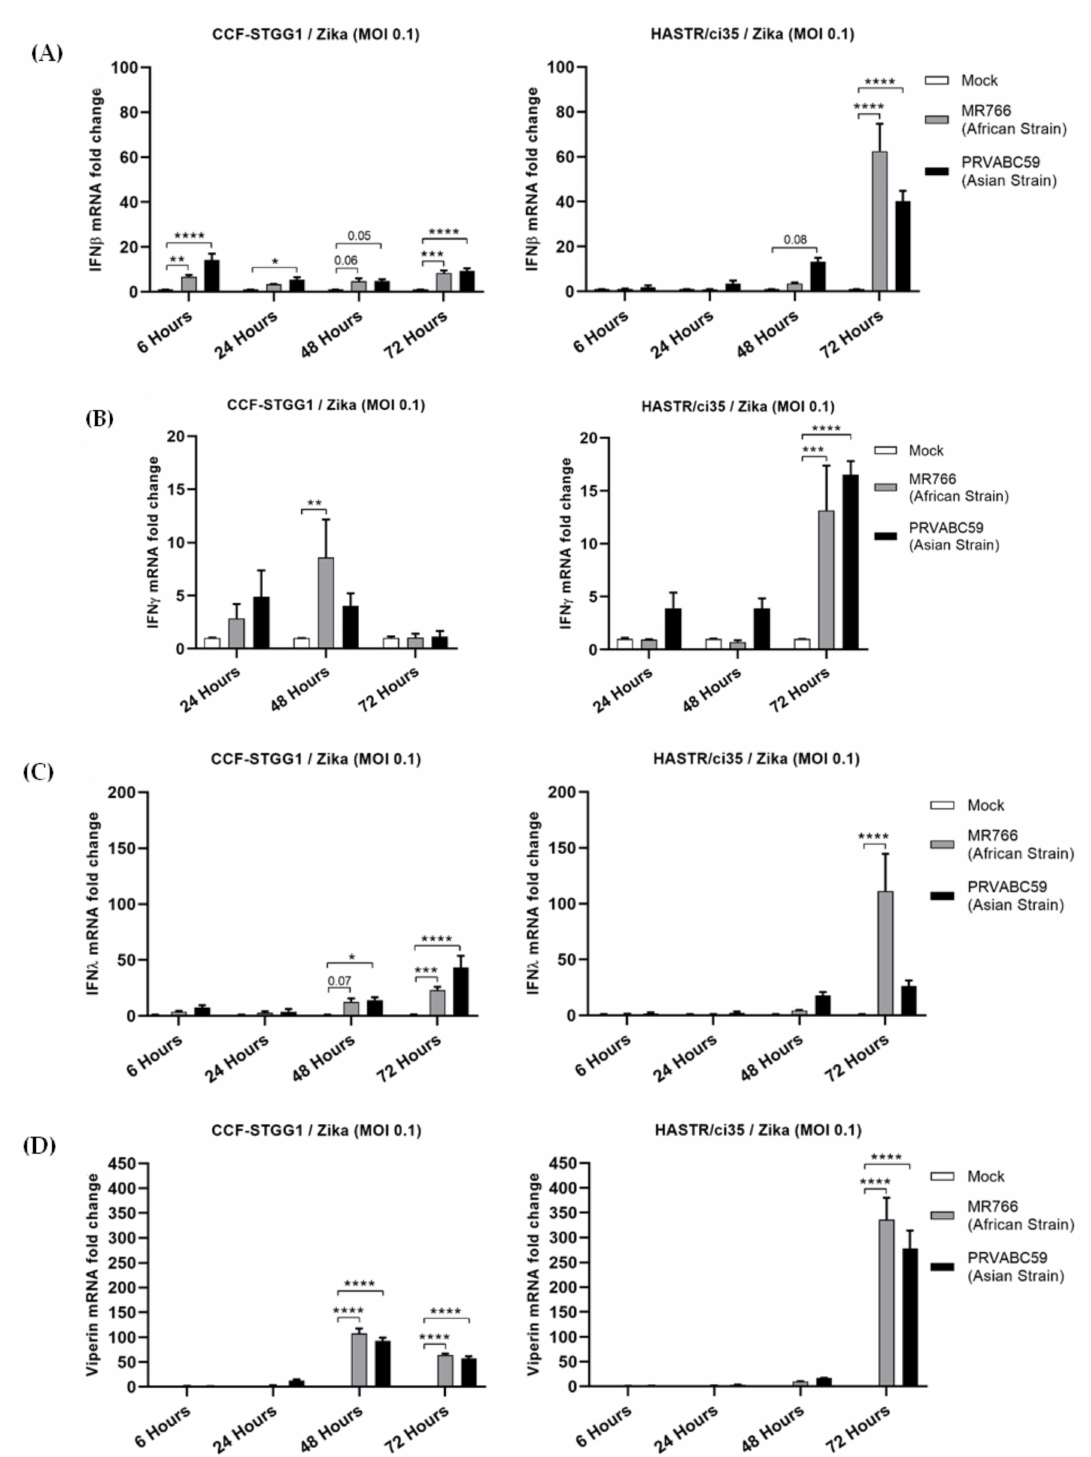
Figure 3. Comparable expression of type I (IFN- β ) ( A ), II (IFN- γ ) ( B ), III (IFN- λ ) ( C ) interferons and a broad-spectrum antiviral inter-feron-stimulated gene (ISG) viperin ( D ) in resistant (CCF-STTG1) and susceptible (HASTR/ci35) astrocyte cells following ZIKV infection. Both cells were infected at an MOI of 0.1 and mRNA expression was measured at 6-, 24-, 48- and 72-hour timepoints. Data were normalised to the 36b housekeeping gene and expressed as a fold change relative to mock-infected control (data are shown as means ± SEM, n = 3). *, **, *** and **** demonstrate significant differences between biological conditions by p < 0.05, p < 0.01, p < 0.001 and p < 0.0001,